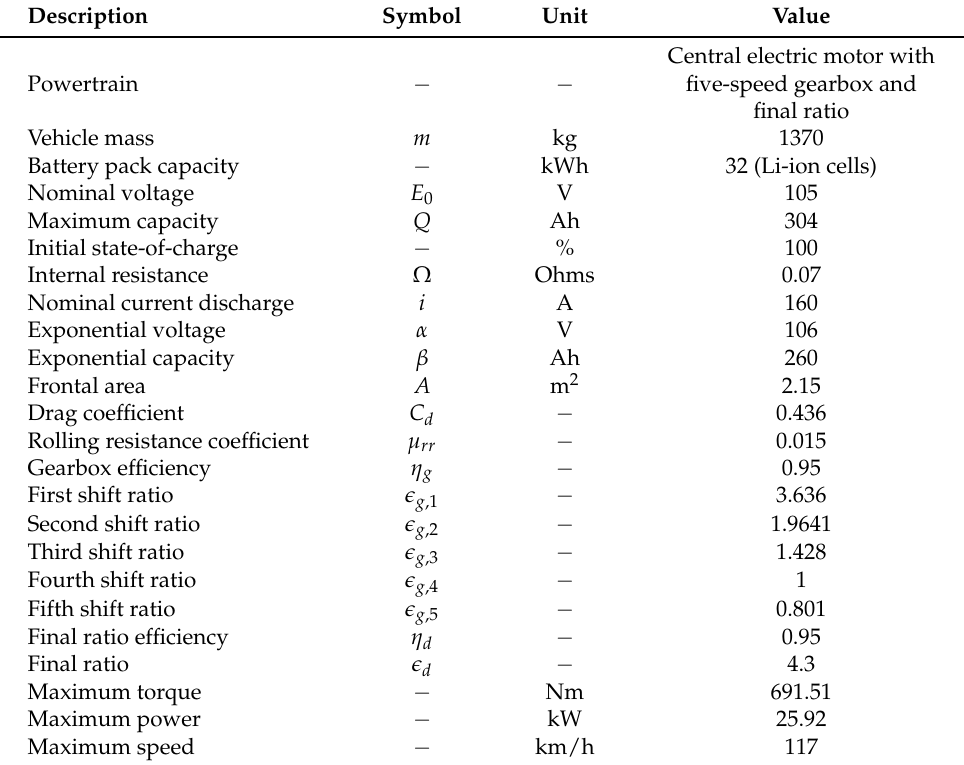
Table 1. Vehicle features.